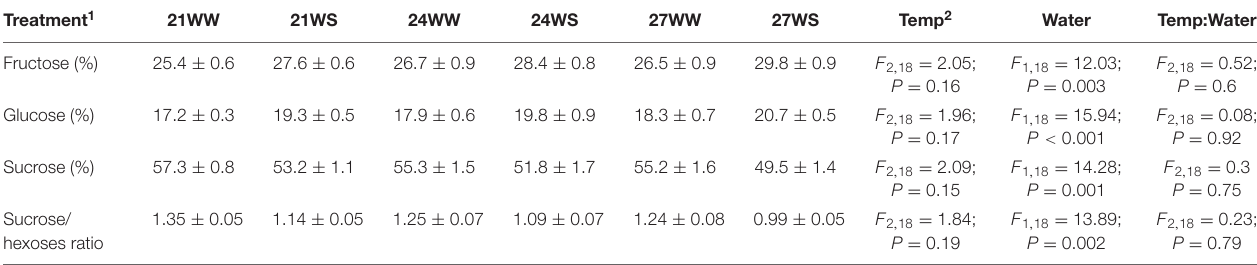
TABLE 1 | Effects of temperature and water stress on nectar sugar composition of Borago officinalis 3 weeks after stress induction. Treatment 1 21WW 21WS